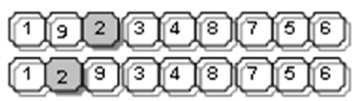
Figure 10. The SM procedure.